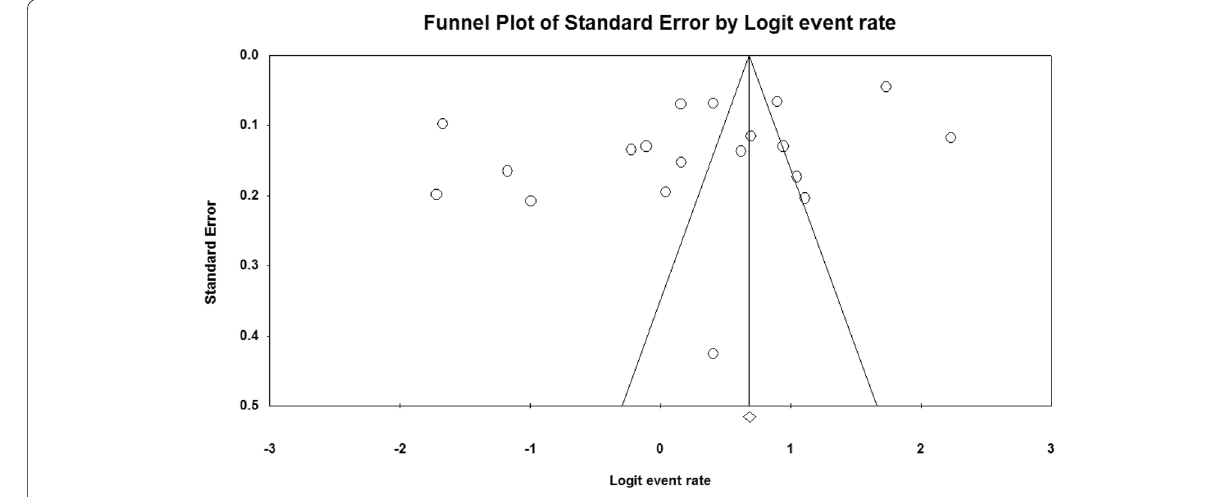
Fig. 2 Funnel plot for checking publication bias